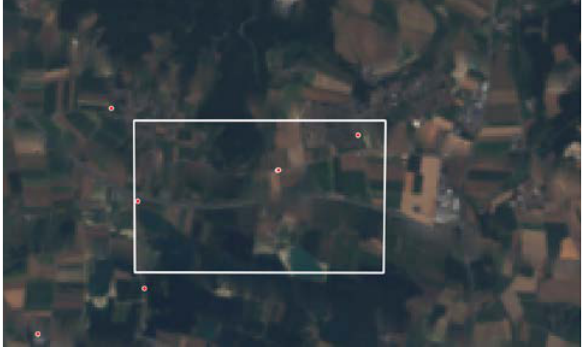
Figure 9 Detail of a Landsat image for day 207 year 2013 (white rectangle indicates borders of the aerial image from Figure 3)